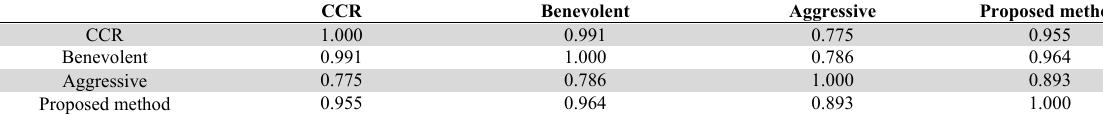
The correlation test for seven biomass fuel briquettes